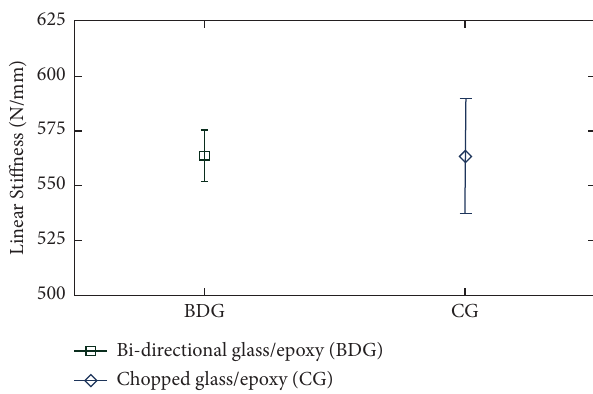
Figure 4: Linear stiffness for bidirectional and chopped laminates.